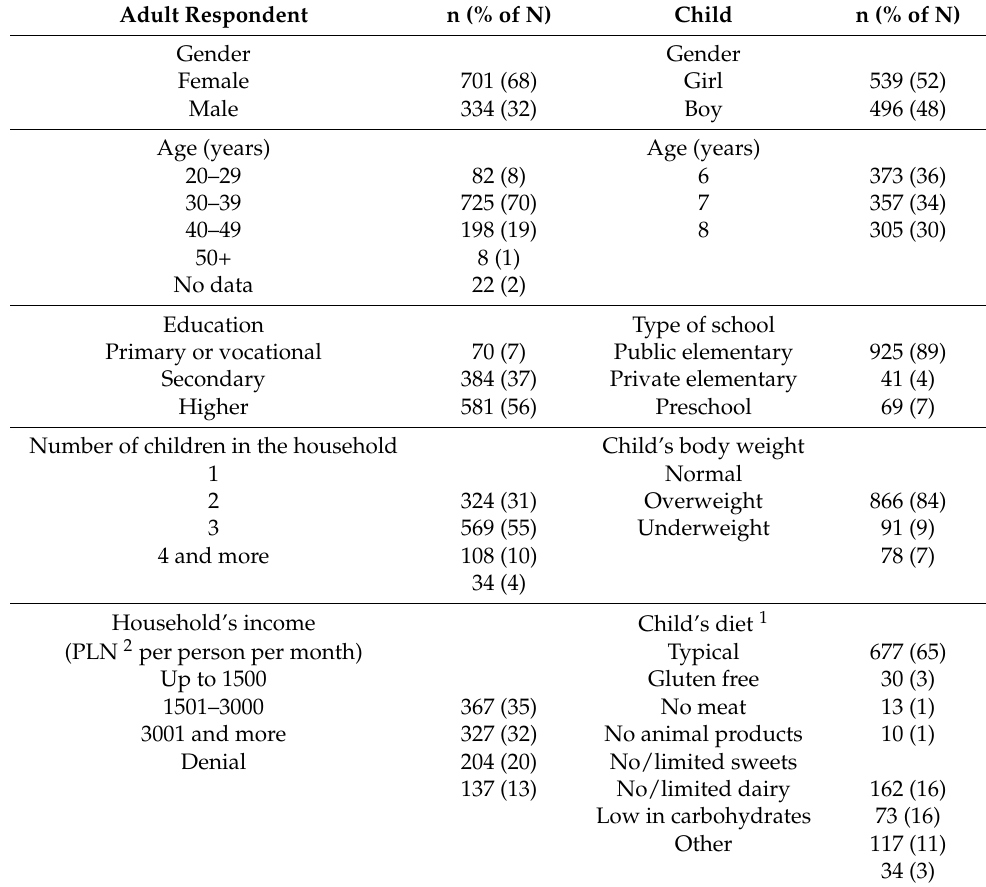
Table 1. Socio-demographic characteristics of respondents and their